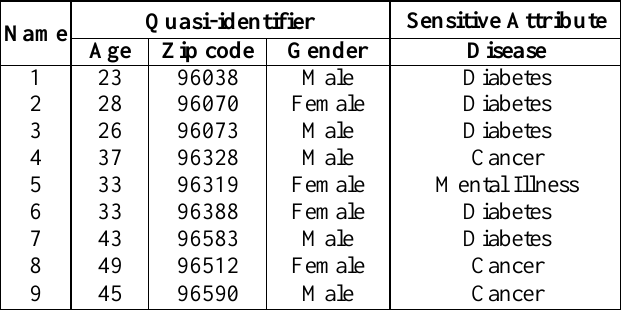
Table 1. An example of different types of attributes in a relational